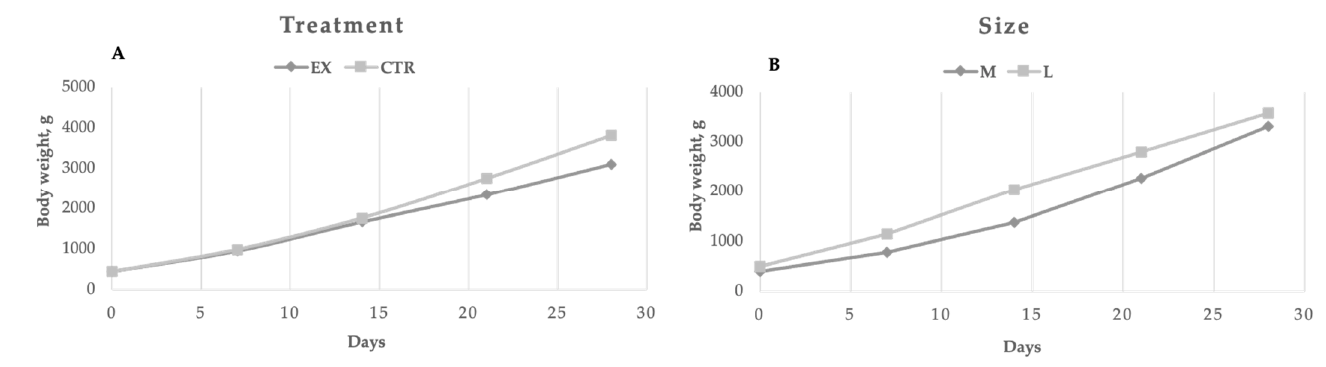
Figure 2. Puppies growth dynamic for CTR group (n = 42) and EX group (n = 67) in function of the diets ( A ) and the size ( B ).